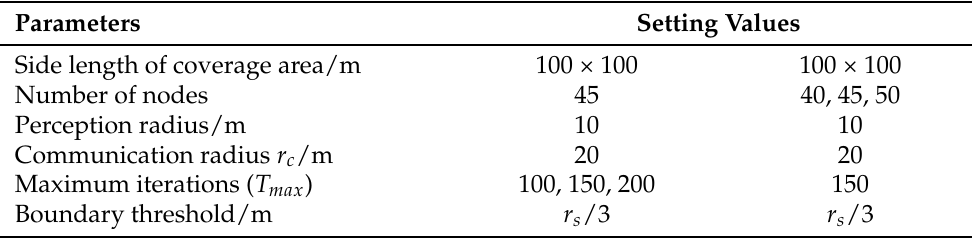
Table 6. Node coverage parameter